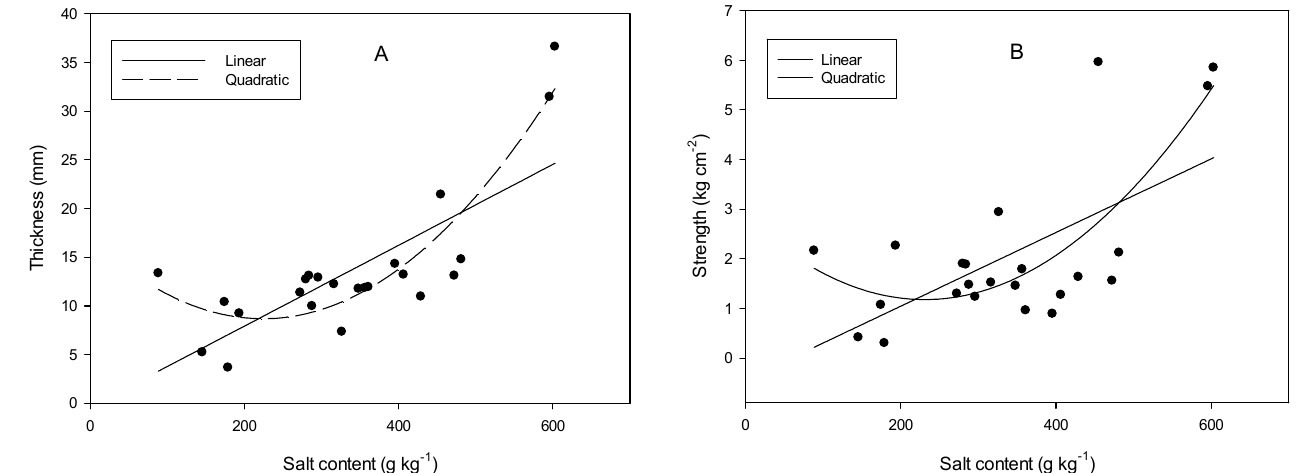
Figure 6. Correlations among the thickness, strength, and salt content of salt crusts in the Tarim River Basin: ( A ) a correlation between the thickness and salt content; ( B ) a correlation between the strength and salt content.